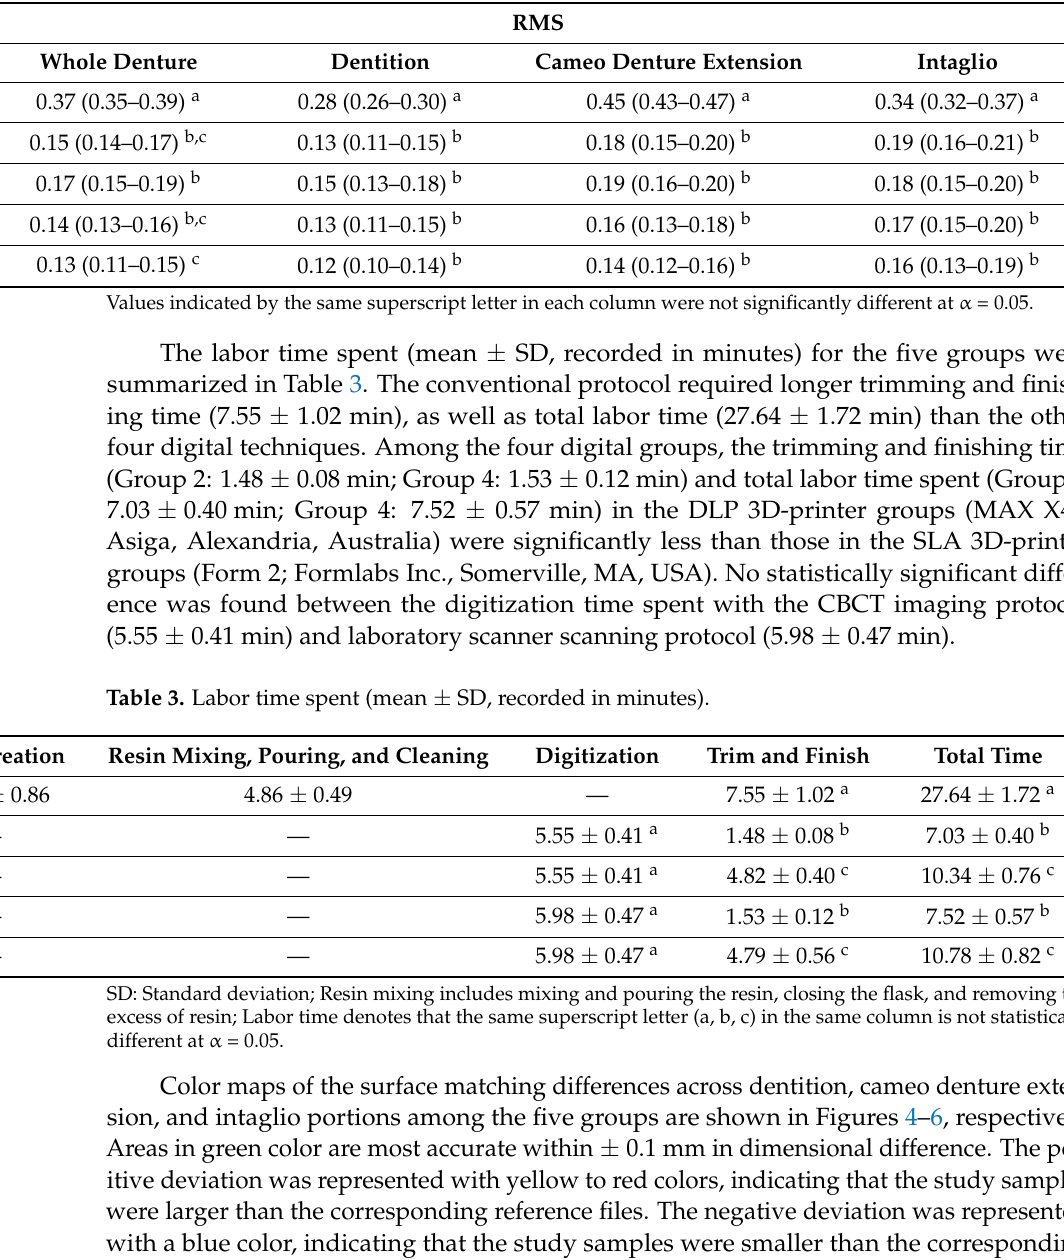
Table 2. Root mean square (RMS, measured in mm) comparisons among groups, mean (95% CI).